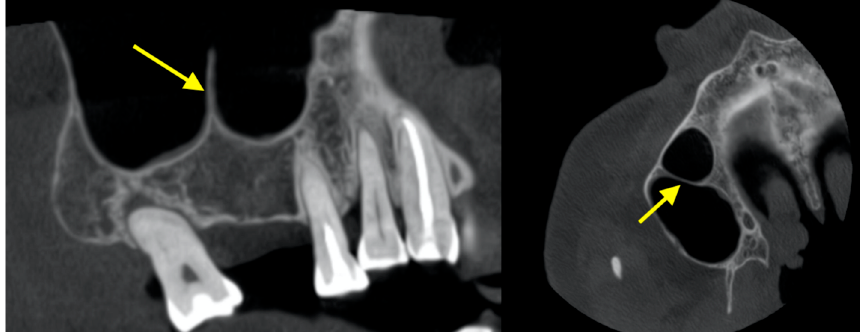
Figure 2. Nasal septum on the sinus floor.